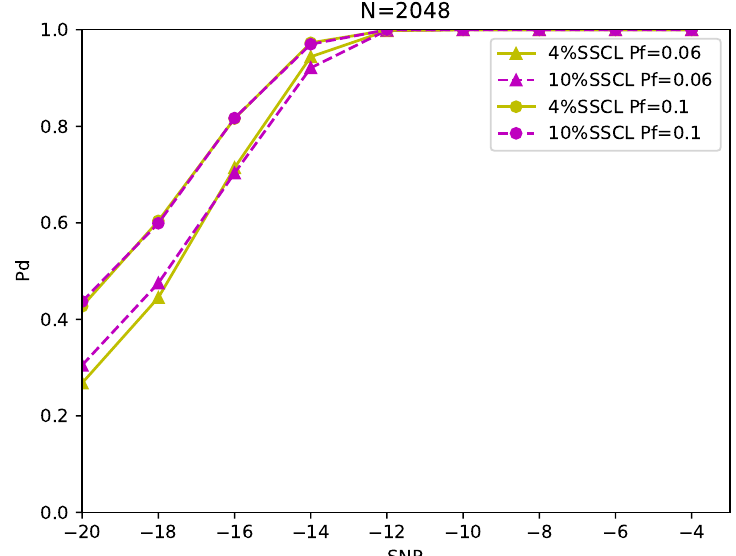
Figure 9. Detection probability when N = 2048.